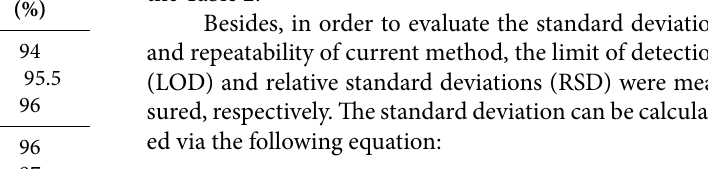
Table 1. Adsorption of Erythrosine dye from chicken slaughter- house and hospital wastewaters. Sample Added dye